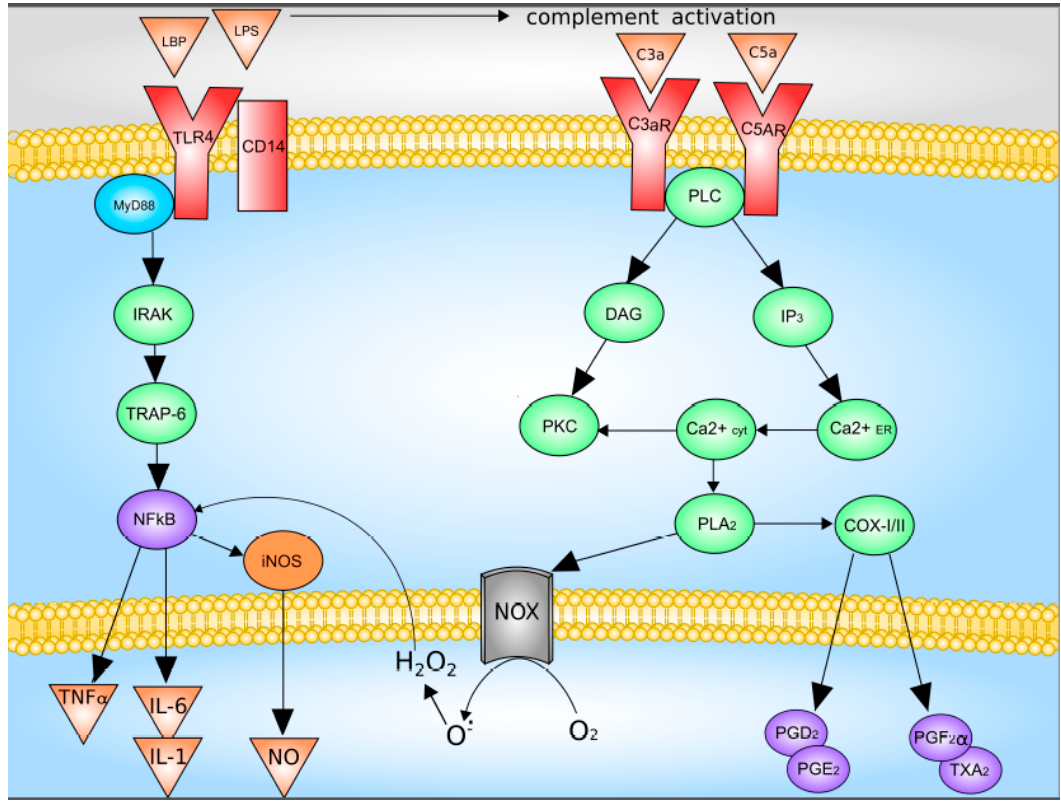
Figure 2. Mechanisms of Kupffer cell activation. C3 and C5, complement factor 3 and 5; C3a and C5a, activated complement factor 3 and 5; CD14, CD14 receptor; COX-I/II, cyclooxygenase-I/II; DAG, diacylglycerol; H 2 O 2 , hydrogen peroxide; iNOS, inducible nitric oxide synthase; IL-1,